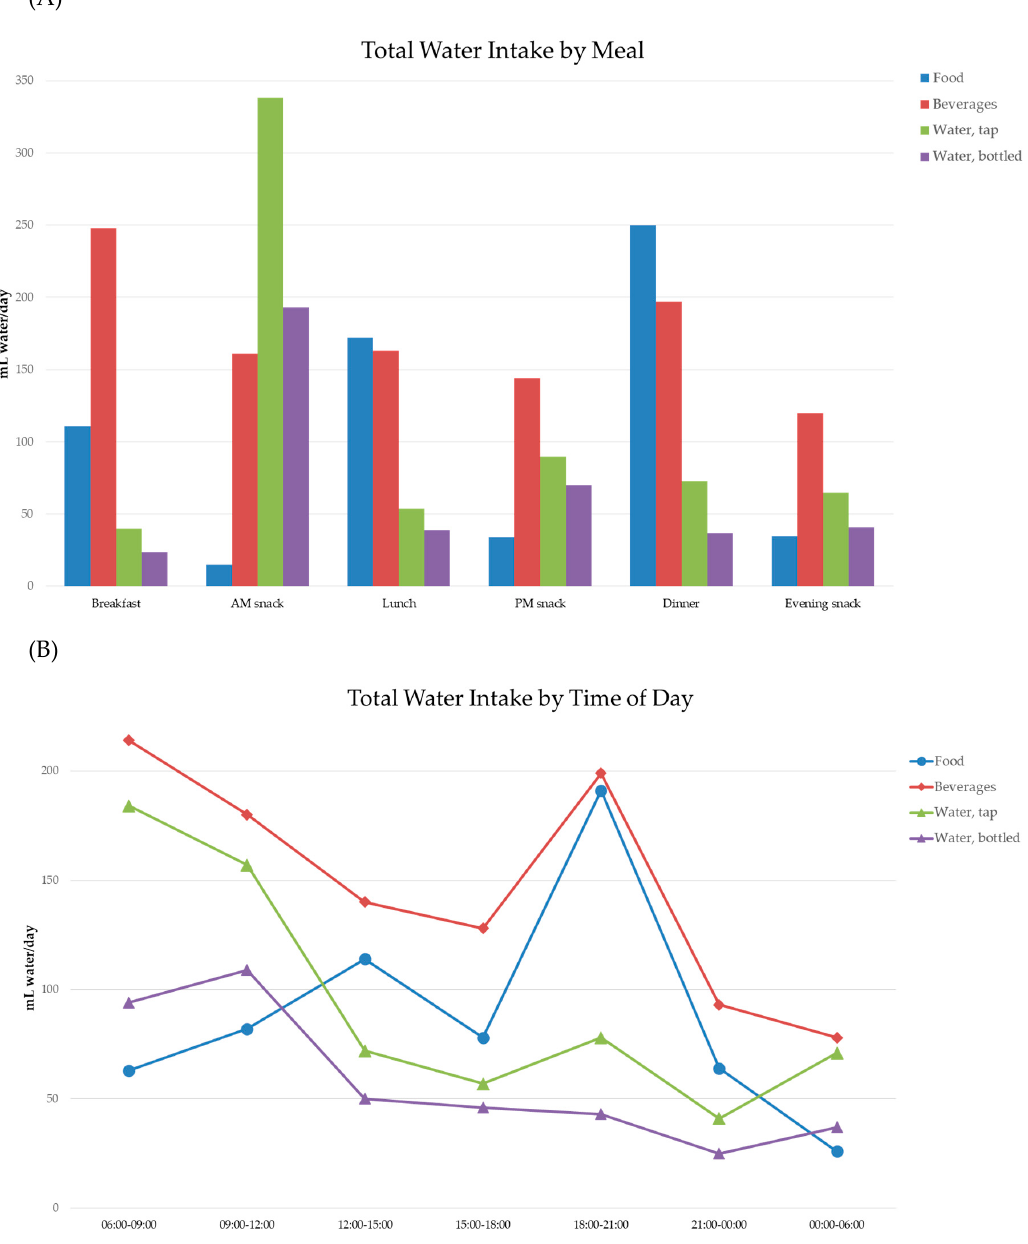
Figure 1. ( A ) (top panel) Total water intake from water, beverages, and foods by eating occasion. ( B ) (bottom panel) Total water intake from water, beverages, and foods by time of day. Data are for participants > 4